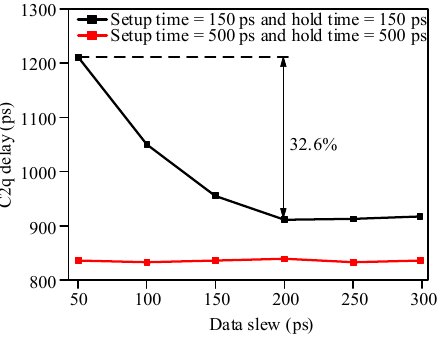
Figure 7. Effects of data transition on clock ‐ to ‐ q delay.